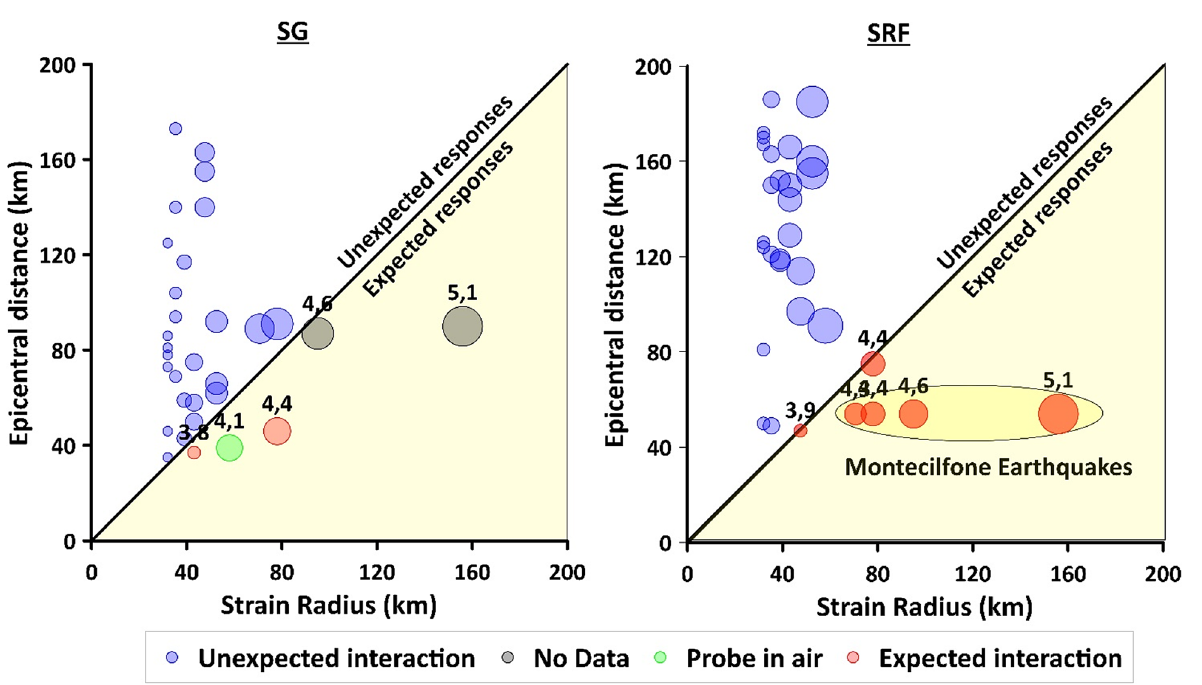
label indicates the M Fig. 6 Seismic events with M ≥ 3.5 in the R – D plane, where R is the earthquake). Only red circles are taken into w w strain radius of the precursory manifestation zone, and D is the epi- consideration due to lack of Rn data, sensor emersions, and unex- central distance (km) from the two springs [49, 50]. Earthquakes, pected interactions that are displayed with black, green and blue for which an interaction between gas-geochemical and seismic circles, signals was supposed, fall into the “expected responses” area (the